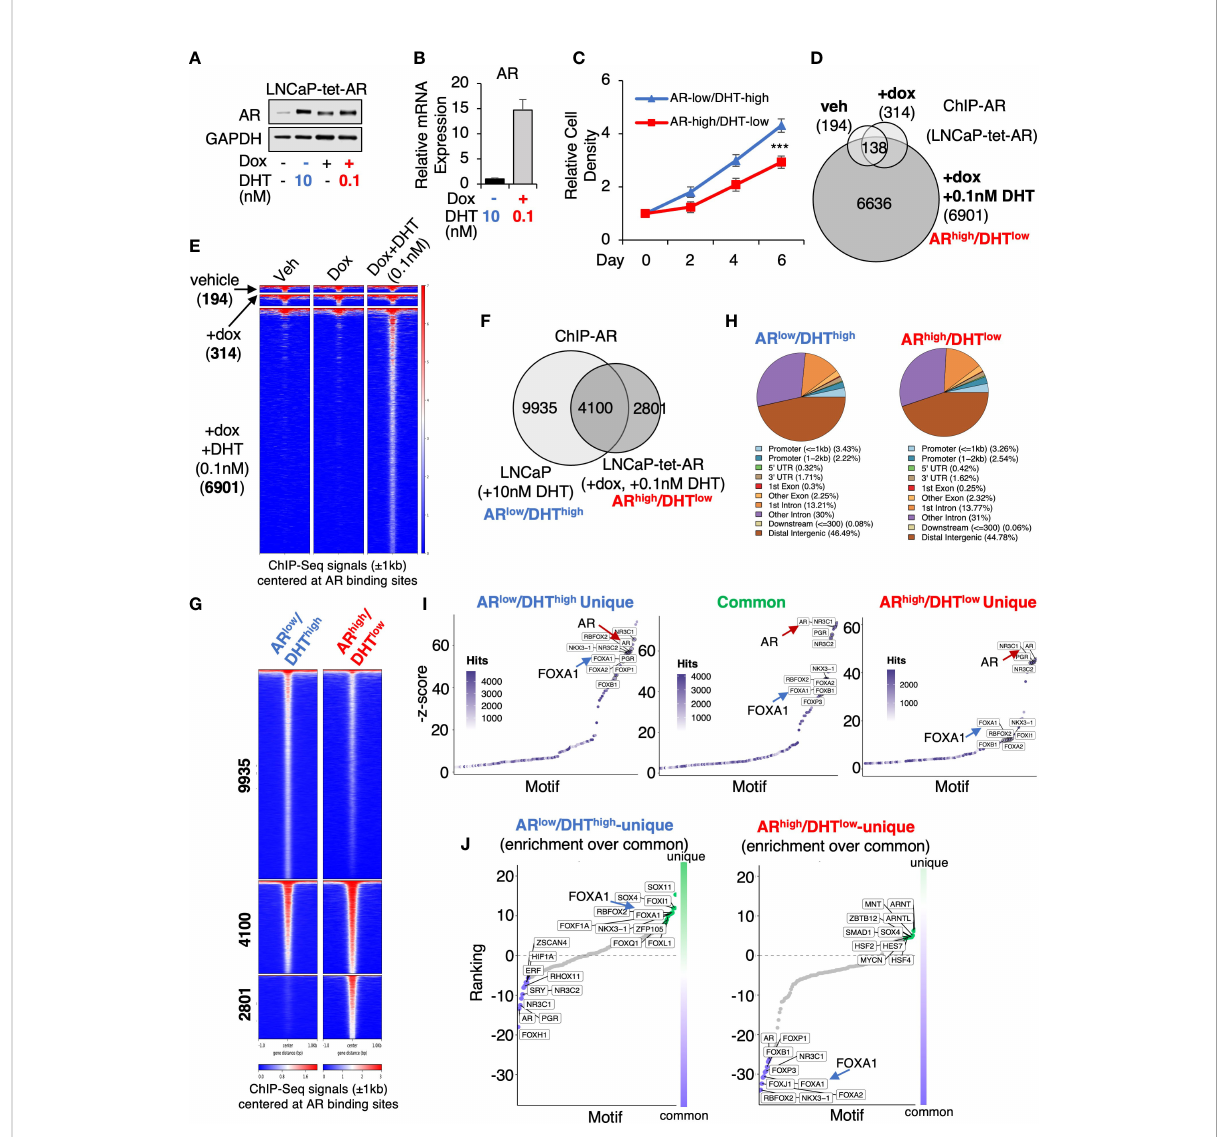
FIGURE 1 AR chromatin binding is altered in AR high /DHT low cells. (A) Immunoblotting for AR in LNCaP cells stably expressing tetracycline-regulated AR (LNCaP-tet-AR). (B) mRNA expression of AR in these cells (measured by qRT-PCR). (C) Proliferation of LNCaP-tet-AR cells treated with 10 nM DHT alone or with 0.25 µg/ml doxycycline plus 0.1 nM DHT for 0-6d. (D) Venn diagram for ChIP-AR peaks in LNCaP-tet-AR cells treated with vehicle, doxycycline alone, or doxycycline plus DHT (0.1nM for 4h). (E) Heatmap view for ChIP-seq signal intensity at these sites. (F) Venn diagram for ChIP-AR peaks in parental LNCaP cells treated with 10 nM DHT ( AR low /DHT high ) and in LNCaP-tet-AR cells treated with 0.25 µg/ml doxycycline and 0.1 nM DHT ( AR high /DHT low ). (G) Heatmap view for ChIP-seq signal intensity at clustered sites. (H) Genomic distribution for AR binding peaks. (I) Motif enrichment analysis for clustered AR binding sites (motifs were ranked based on z-score). (J) Unique motif enrichment by comparing motif enrichment for unique sites over common